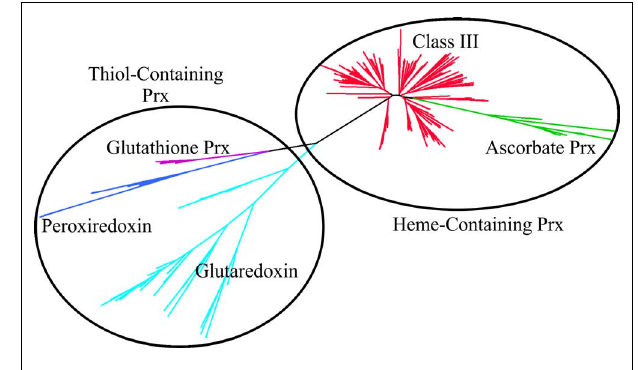
FIGURE 1 | Phylogenetic clustering of heme- and thiol peroxidases (Prx) present in the switchgrass genome. Heme peroxidases (oval) consist of the class I ascorbate peroxidases (green), and class III peroxidases (red).Thiol peroxidases (circle) consist of the glutathione peroxidases (purple), peroxiredoxin (blue) and glutaredoxin